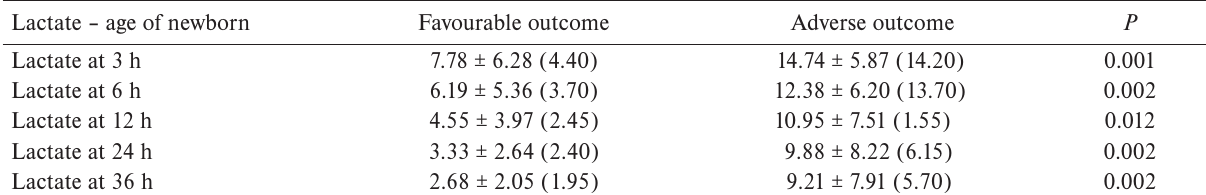
Table 2. Change in lactate levels (mmol/L) in both groups of patients.